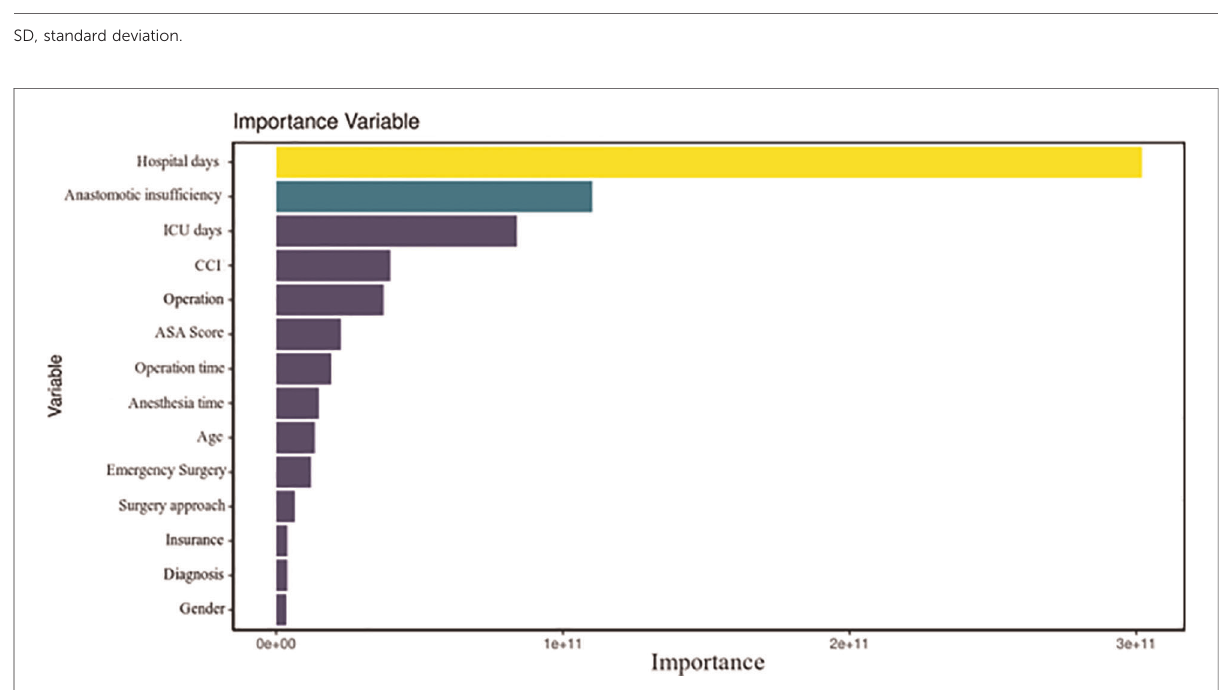
FIGURE 1 Total decrease in node impurities, measured by the Gini index from splitting on the variable, averaged over all